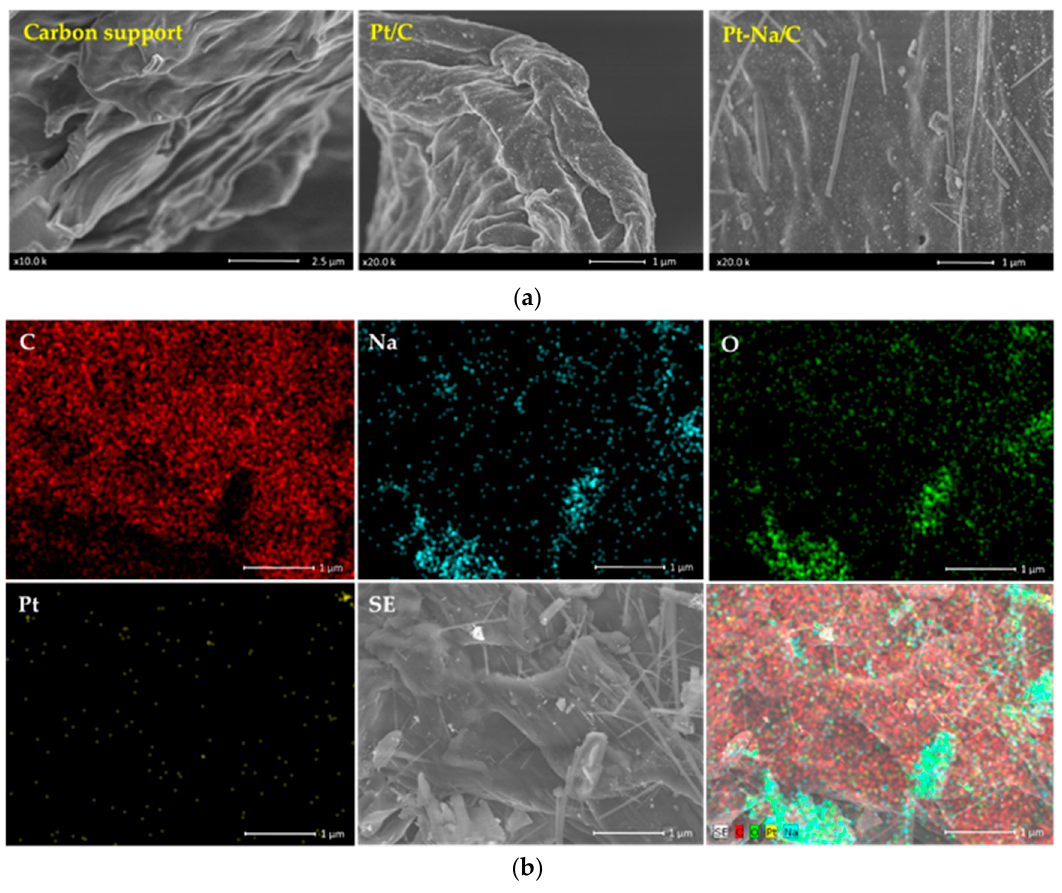
Figure 3. ( a ) SEM micrographs of the samples: carbon support, Pt/C, and Pt–Na/C, and ( b ) SEM micrograph of Pt–Na/C catalyst including the elemental mapping obtained by EDX analysis.